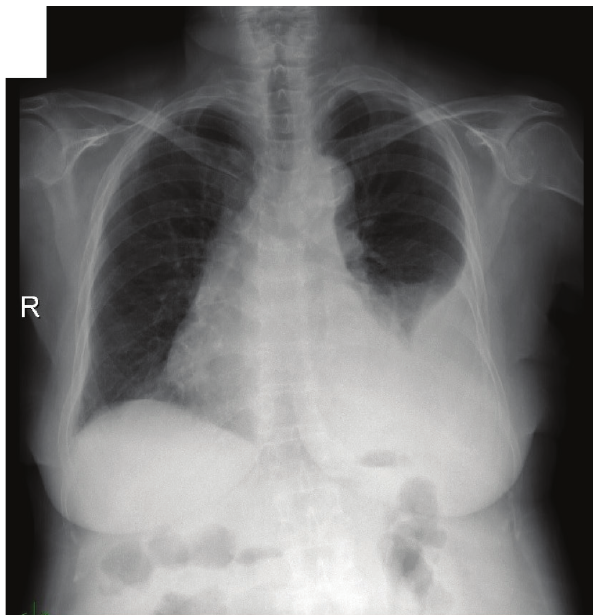
Figure 1: Bilateral pleural effusion under IM treatment Figure 2: Serum creatinine levels of the patient